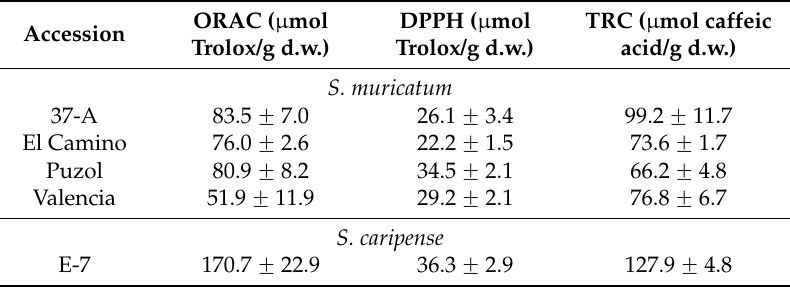
Table 3. Antioxidant activity of fruit samples of pepino ( S. muricatum ) and its wild relative S. caripense capacity, oxygen radical absorbance capacity (ORAC), and total reducing capacity (TRC) based on the Folin–Ciocalteu reagent